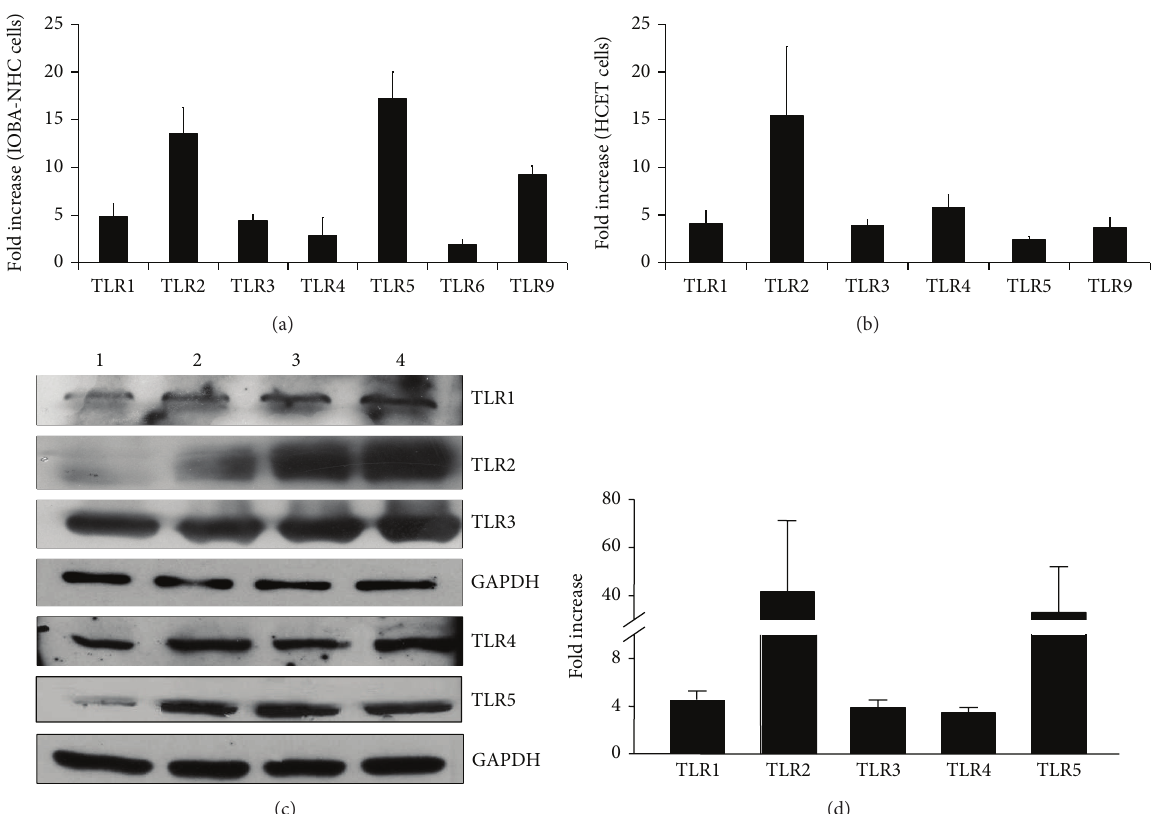
Figure 2: TLR mRNA and protein expression in airlifted immortal human corneal (HCET) and conjunctival epithelial cells (IOBA-NHC). (a) Averaged fold increase of TLR mRNA in IOBA-NHC cells. The increase was statistically significant for each TLR. (b) Averaged fold increase of TLR mRNA in HCET cells. The increase was statistically significant for each TLR. Cells were airlifted for 10 days. TLR mRNA level was determined by qPCR and compared to submerged cells. The experiment was repeated 3 times. 𝑌 error bars represent the standard deviation of the averaged results. (c) Micrographs of a representative western blot showing TLR protein expression in IOBA-NHC cells. Lane 1: submerged-cultured; lane 2: 3 days after airlifting culture; lane 3: 7 days after airlifting culture; lane 4: 10 days after airlifting culture. Glyceraldehyde 3-phosphate dehydrogenase (GAPDH) protein was probed as loading control. (d) Averaged TLR protein increase in IOBA- NHC cells 10 days after airlifting culture compared to submerged-cultured cells. X-ray films from 2 independent western blot experiments were scanned in a densitometer, and the results were averaged. The increase was statistically significant for each TLR protein tested.